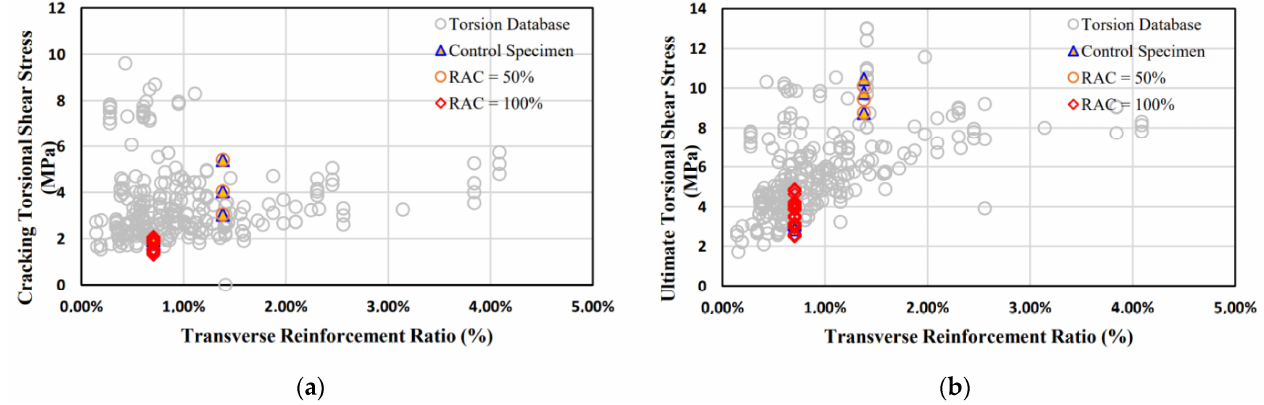
Figure 5. Effect of transverse reinforcement: ( a ) on cracking torsional shear stress; ( b ) on ultimate torsional shear